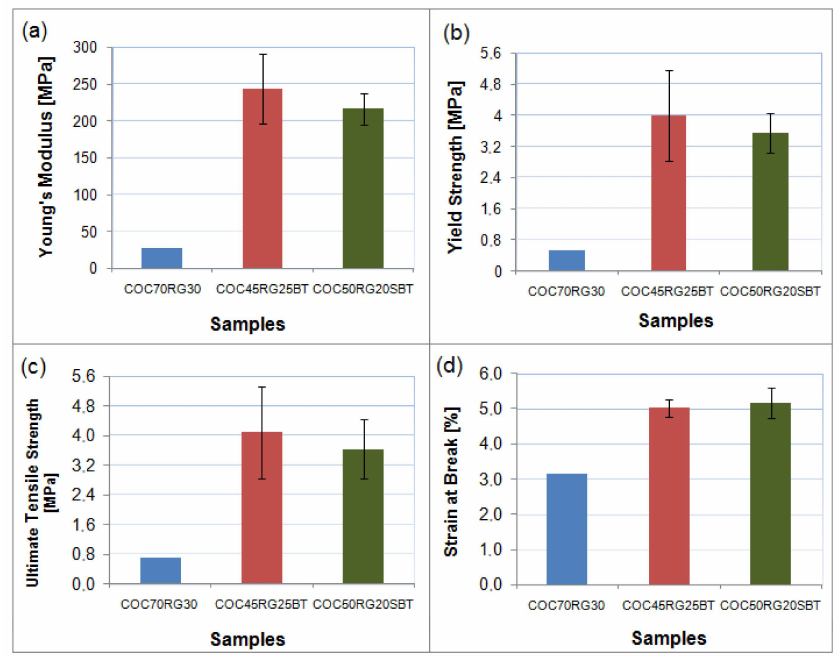
Figure 5. Plots of tensile properties of COC + RG with banana fibers and sugarcane bagasse